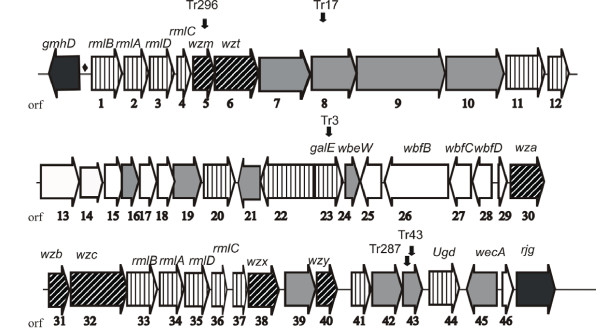
Map of the CPS/O-antigen region of V. cholerae NRT 36s. JUMPstart site is indicated by a diamond. Transposon insertion sites are indicated by black arrows. Design patterns of open reading frames indicate different classes of genes: vertical lines, pathway genes; diagonal lines, processing and transportation genes; grey box, glycosyltransferase; white box, functions not clear.